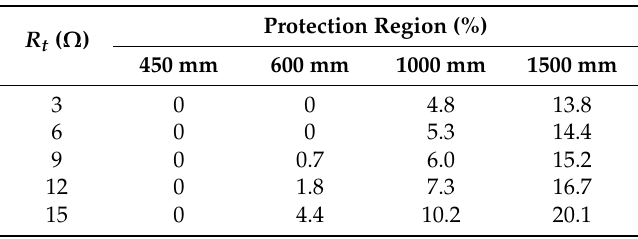
Figure 13. Influence of tower footing resistance on protection region of arcing horns. Table 2. Influence of tower footing resistance on protection region of arcing horns.